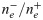
AUPR score of the considered multi-task methods on the GPCR family as a function of the ne-/ne+ ratio, for a varying number ne+ of extra-task positive pairs.(a): NN-MT-family (family hierarchy kernel). (b): NN-MT (sequence kernel). (c): RN-MT-family (family hierarchy kernel). (d): RN-MT (sequence kernel). The blue horizontal line corresponds to the MT-intra method trained only on intra-task pairs. Numerical values can be found in Supporting Information, respectively S18–S21 Tables.